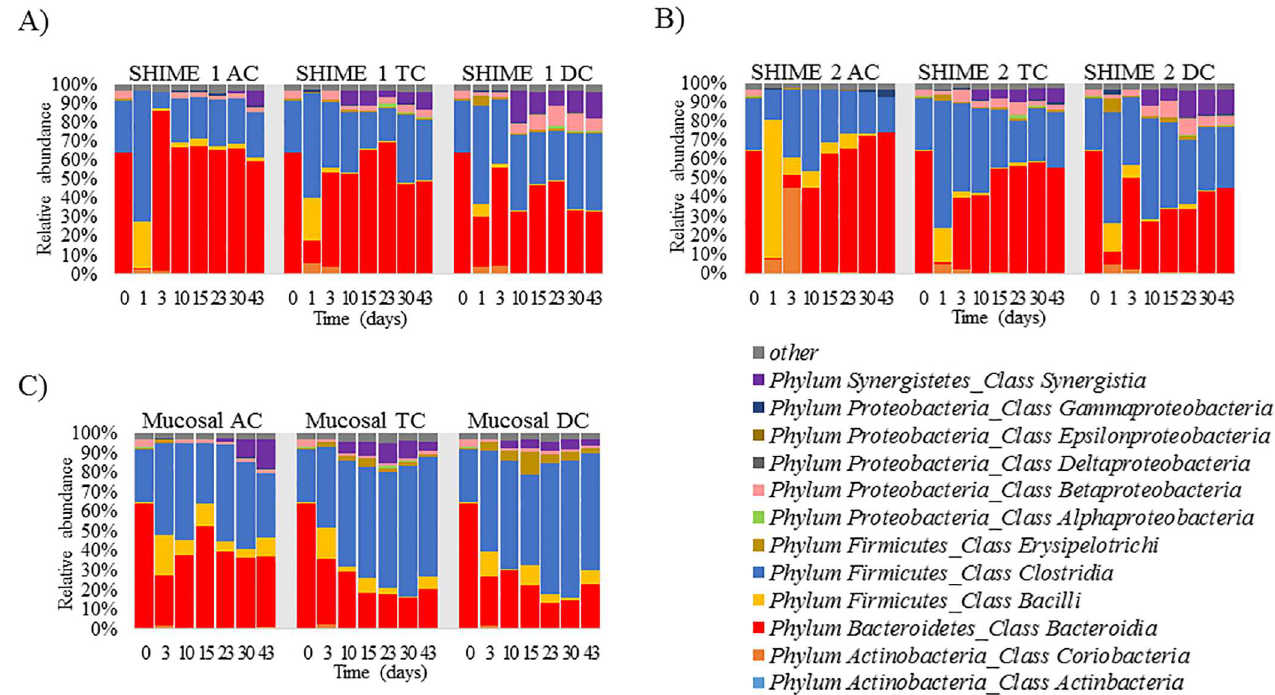
Fig 3. Composition of the gut microbial communities at the class level. Taxa with > 1% relative abundance in samples are listed, while the rest of taxa are lumped into the “other” category. On the left of each figure, labeled 0, is the composition determined from the fecal homogenate used to inoculate the system. Communities from each region over time established in (A) SHIME 1, Luminal phase; (B) SHIME 2, Luminal phase; (C) SHIME 1, Mucosal phase.